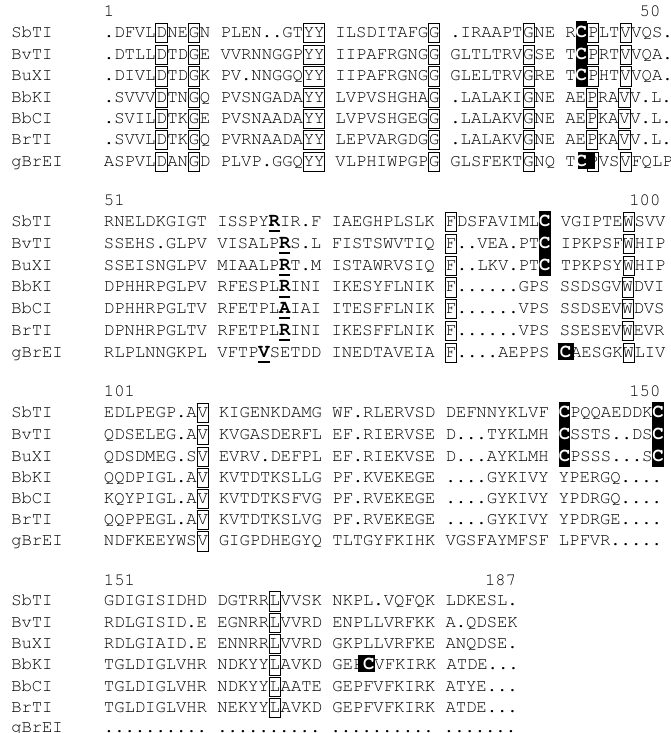
Fig. 2 – Comparison of partial sequences of related Kunitz inhibitors. SBTI, soybean trypsin inhibitor; BvTI, Bauhinia variegata Trypsin Inhibitor (Oliva et al. 2003); BuXI, Bauhinia ungulata Factor Xa Inhibitor (Oliva et al. 2003); BbKI, Bauhinia bauhinioides Kallikrein Inhibitor (Oliva et al. 2001a); BbCI, Bauhinia bauhinioides Cruzipain Inhibitor (de Oliveira et al. 2001); BrTI, Bauhinia rufa Trypsin Inhibitor (Nakahata et al. 2006) and gBrTI Bauhinia rufa elastase Inhibitor, glycosilated form (Sumikawa et al. 2006). Black boxes indicate the reactive site residue for trypsin inhibition. Methionine residues in BuXI are indicated by white